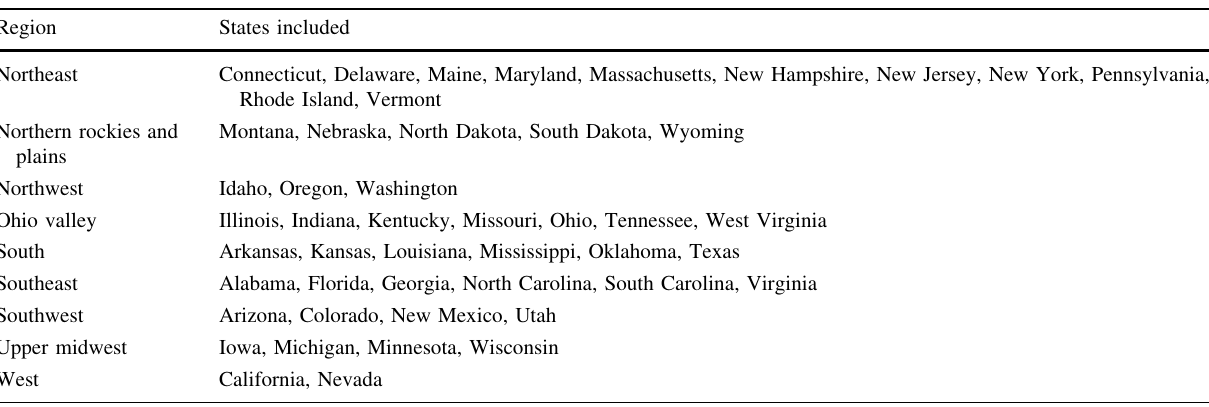
Table 1 Definition of climate regions in the United States, based on the U.S. climate region map published by the National Oceanic and Atmospheric Administration (NOAA). Source